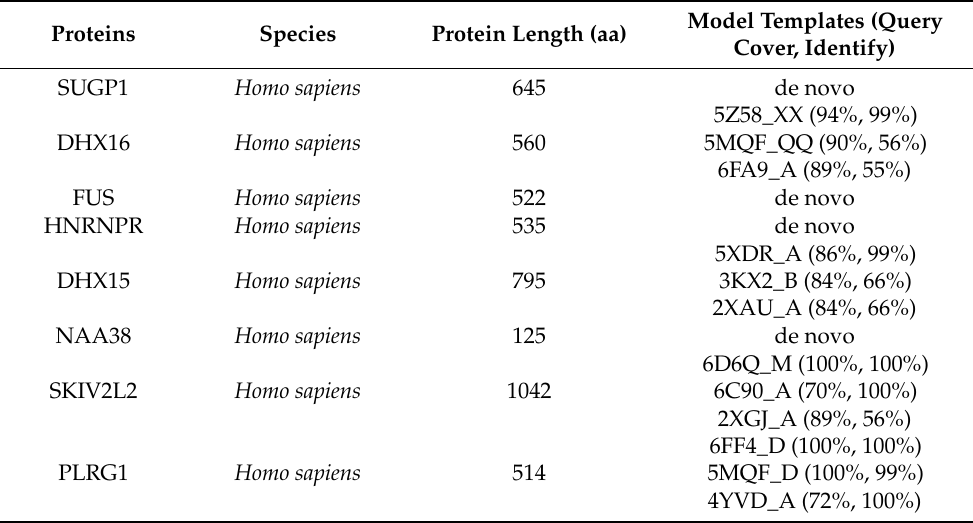
Table 4. Protein